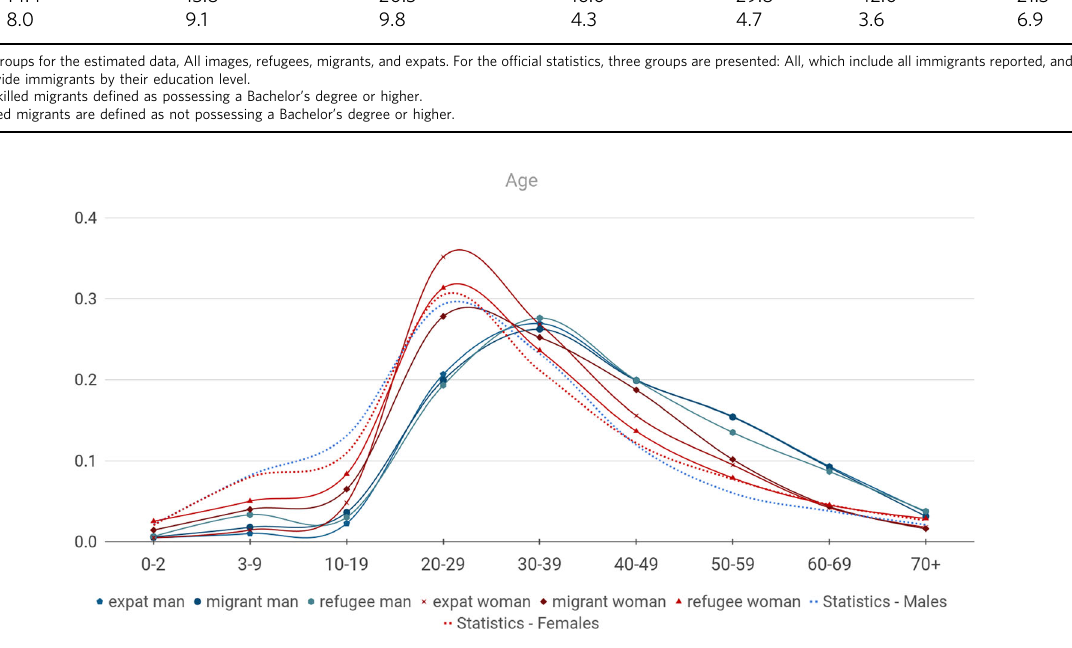
Fig. 1 Estimated age distributions. Plots for all the gender-speci fi c groups (solid lines) and distributions from statistics (dotted lines). Statistics used are from the selected countries Hungary, Italy, The Netherlands, Spain, and